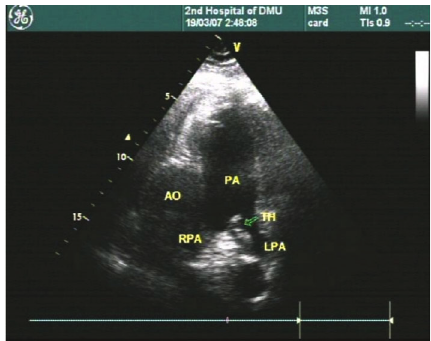
Figure 1: Short-axis section of great artery; sonographic image of thrombus at pulmonary artery bifurcation.